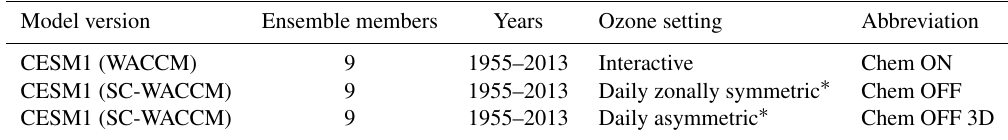
Table 1. Different model settings of CESM1 used in this study and their respective